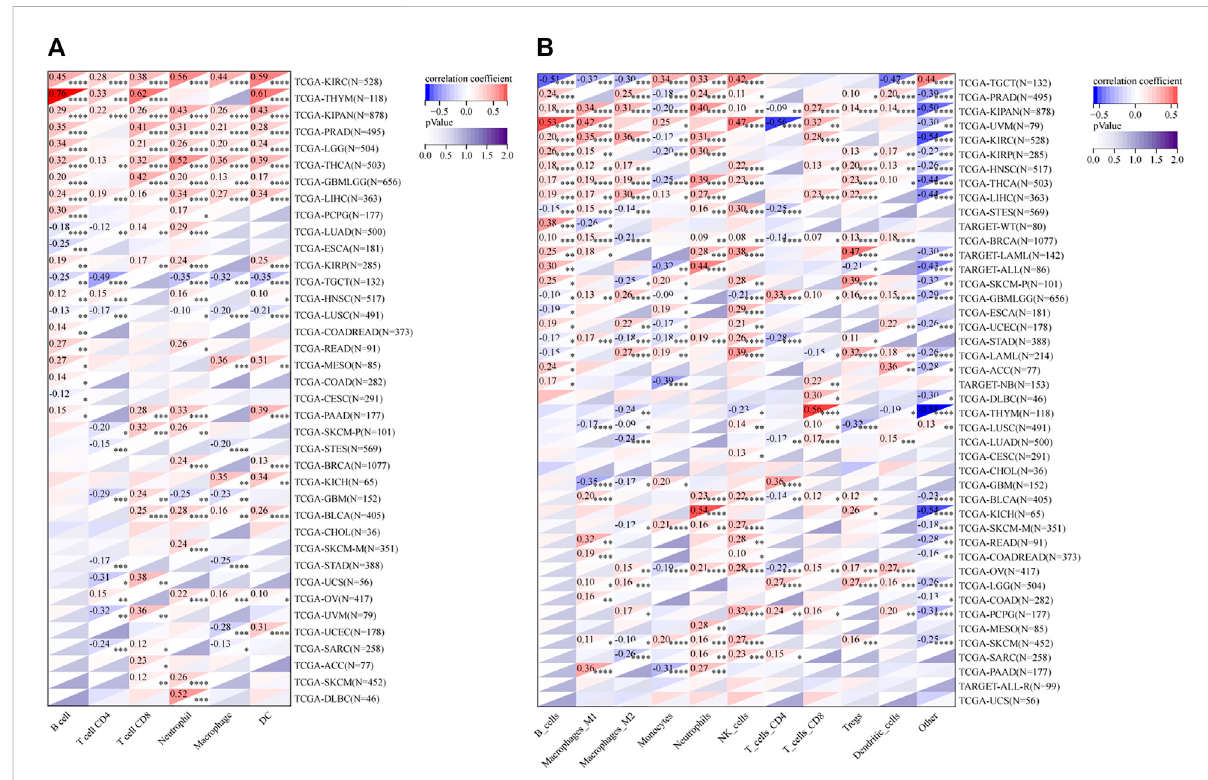
FIGURE 7 Correlation analysis between RAD51AP1 and tumor immune cell in fi ltration in TIMER and QUANTISEQ. (A) TIMER. The expression of RAD51AP1 was signi fi cantly related to tumor immune cell in fi ltration in 37 cancer types. (B) QUANTISEQ. The correlation was signi fi cant in 41 cancer